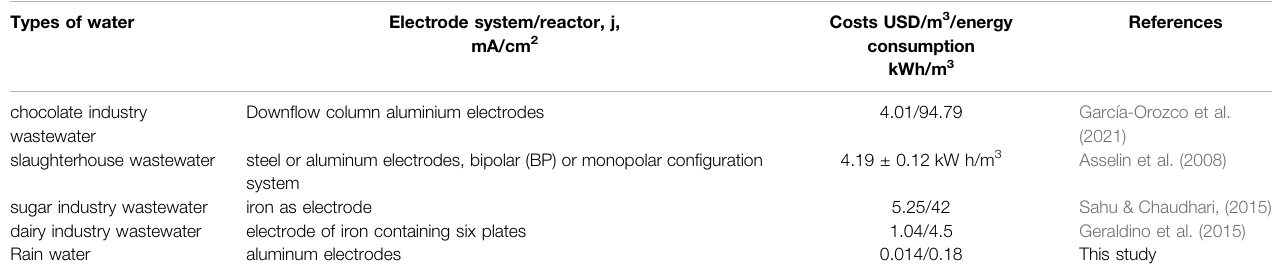
TABLE 5 | Costs and energy consumption of electrochemical treatments with different types of water. Types of